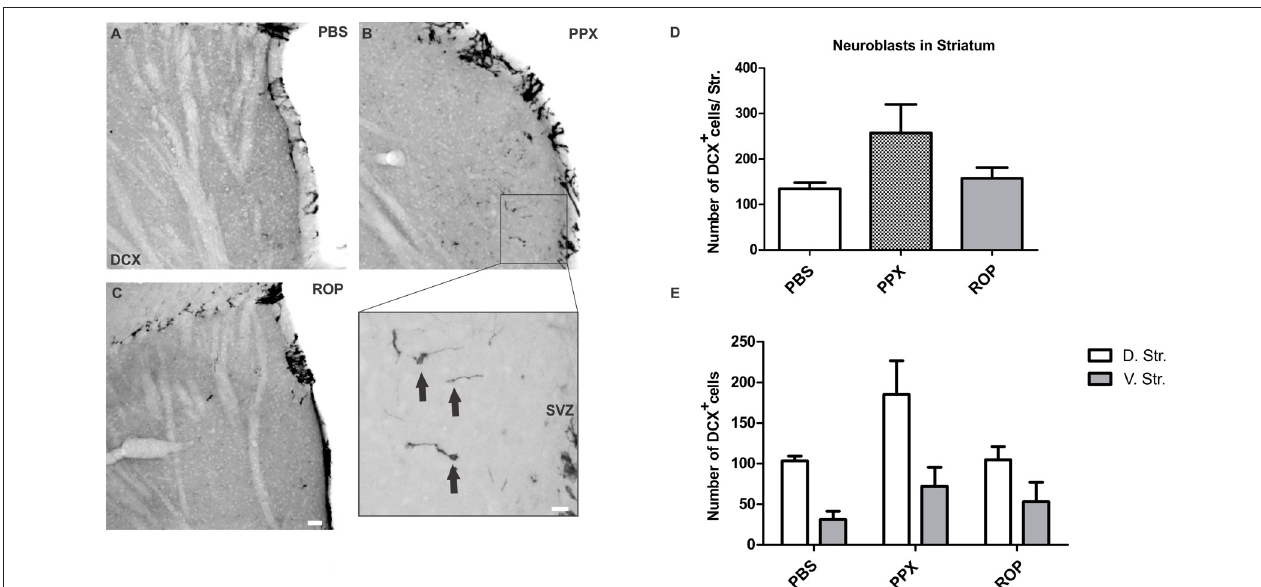
FIGURE 4 | PPX induces the generation of neuroblasts in the dorsal compared to the ventral striatum. Representative stainings of DCX + cells in the striatum showing a low number of neuroblasts in the PBS (A) and in the ROP group (C) , and a higher number in the PPX group (B) . Insert displays the region of interest with DCX + cells at higher magnification. (D–E) Quantification of DCX + neuroblasts in the entire striatum, and separately in the dorsal vs. ventral striatal sub-regions. No significant difference in the number of DCX + cells was observed in the entire striatum for all groups (One-way ANOVA followed by Tukey’s post-hoc test). In contrast, the analysis of striatal sub-regions by using a linear regression model revealed a significant effect of PPX, but not with ROP treatment. Please note that the regression model was calculated based on the square root transformed numbers of DCX neuroblasts, whereas the untransformed numbers are displayed in E . Error bars represent mean ± SEM. Scale bars: 50 µ m (A–C) , 10 µ m (insert). D.Str, dorsal striatum; V.Str, ventral striatum.